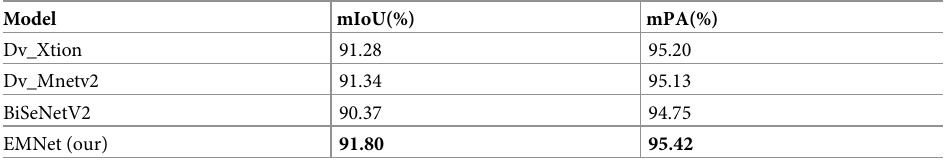
Note: Bold numbers are the best